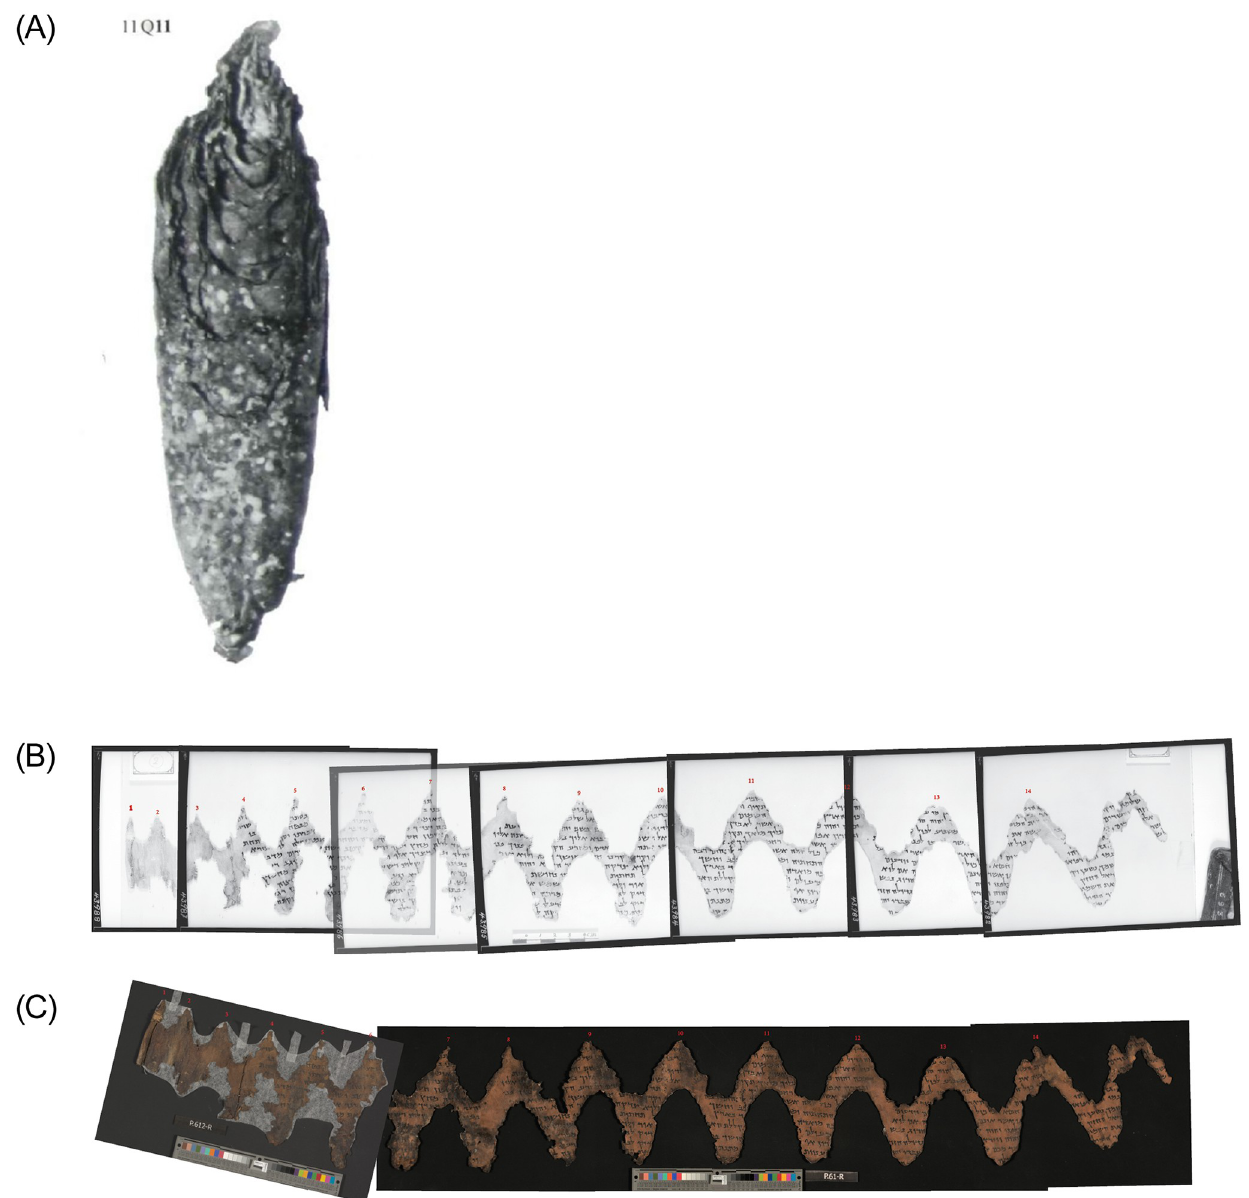
Fig 8. Apocryphal Psalms , 11Q11. (A) Left: prior to unrolling. (B) Upper right: composite of PAM infrared images. (C) Lower right: composite of IAA color images. (Courtesy IAA, LLDSSD. IAA image photographer: Shai Halevi; PAM photographer: Najib Anton Albina.).